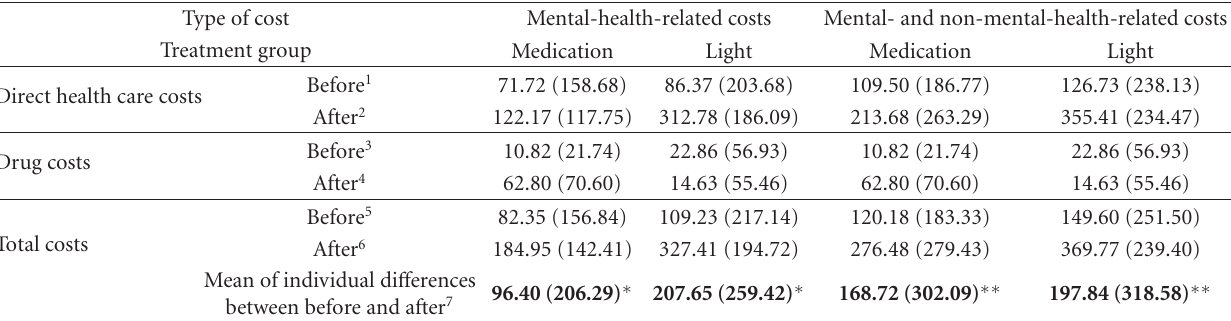
Table 2: Total health care costs and cost di ff erences based on full purchase cost of light box between fluoxetine and light therapy